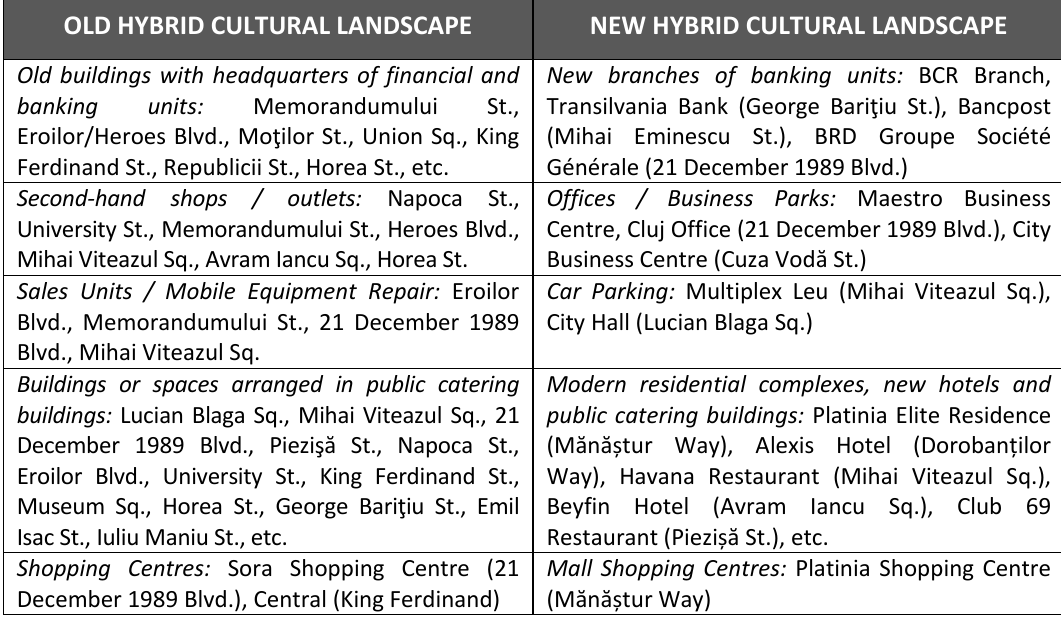
Table 2: Hybrid cultural landscapes – outlining the territorial expression of Cluj-Napoca city centre OLD HYBRID CULTURAL